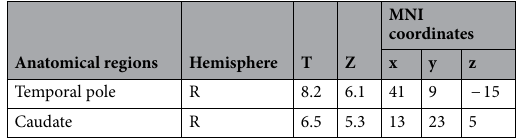
Table 4. Brain regions with increased Cortical thickness in Pandits/Priests compared with Control (Pandit > control).